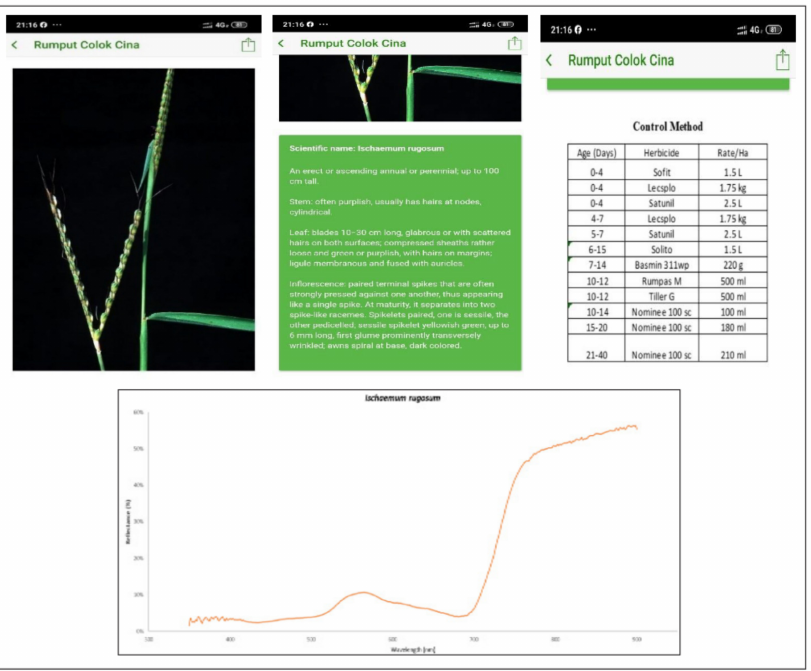
Figure 6. The content of menus, pictures, description, control method, and spectral signature